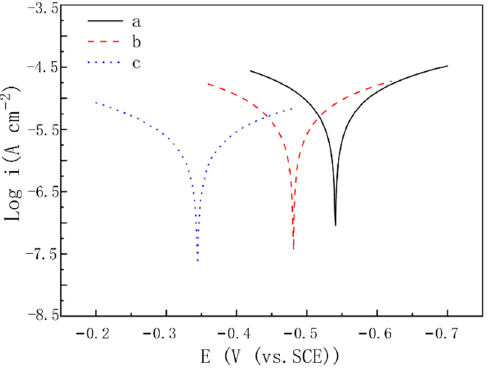
Figure 5. Tafel curves for uncoated CS (a), CS − A − PANI (b), and CS − N − PANI (c) in 3.5 wt% NaCl aqueous solution.